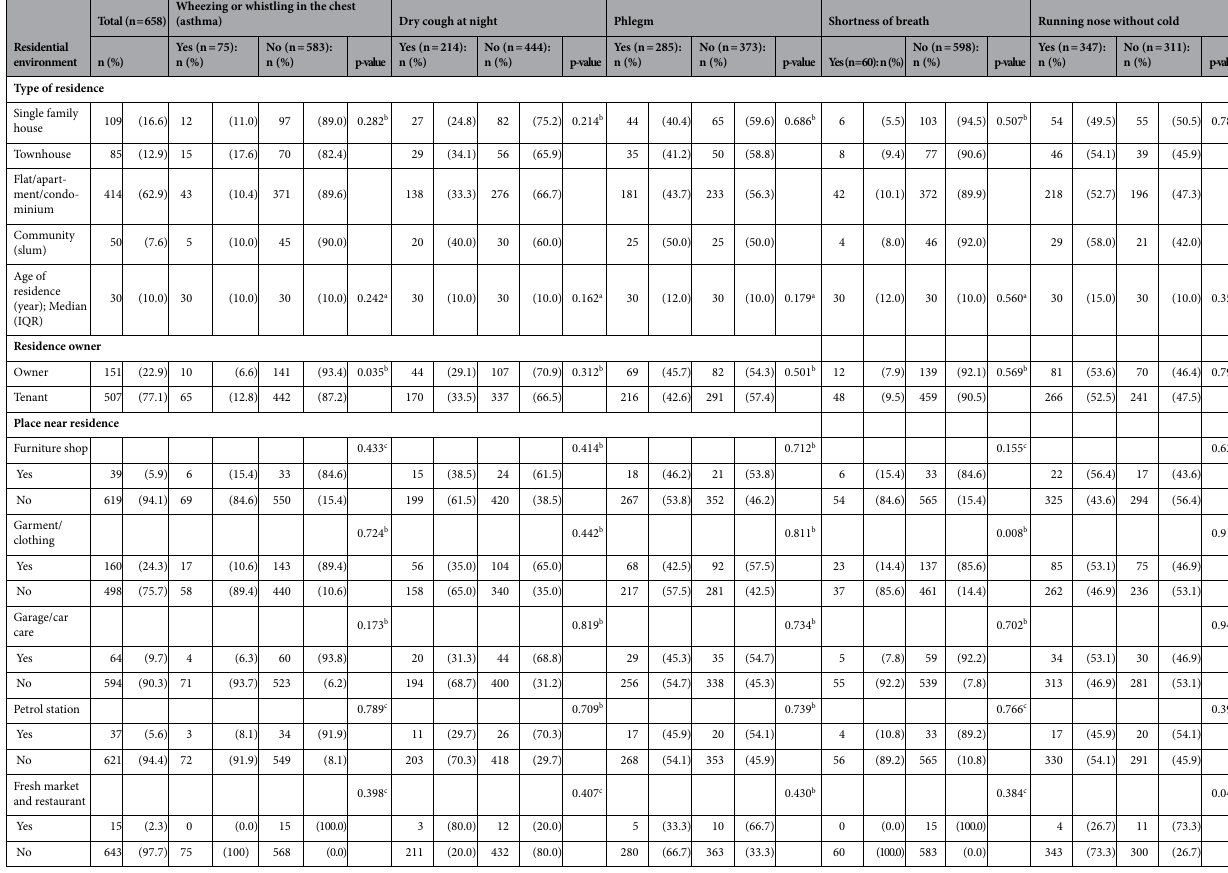
Table 2. Residential characteristics and respiratory/asthma symptoms of primary school Children (n = 658). a Mann–Whitney U test, b Pearson Chi-square test, c Fisher’s exact